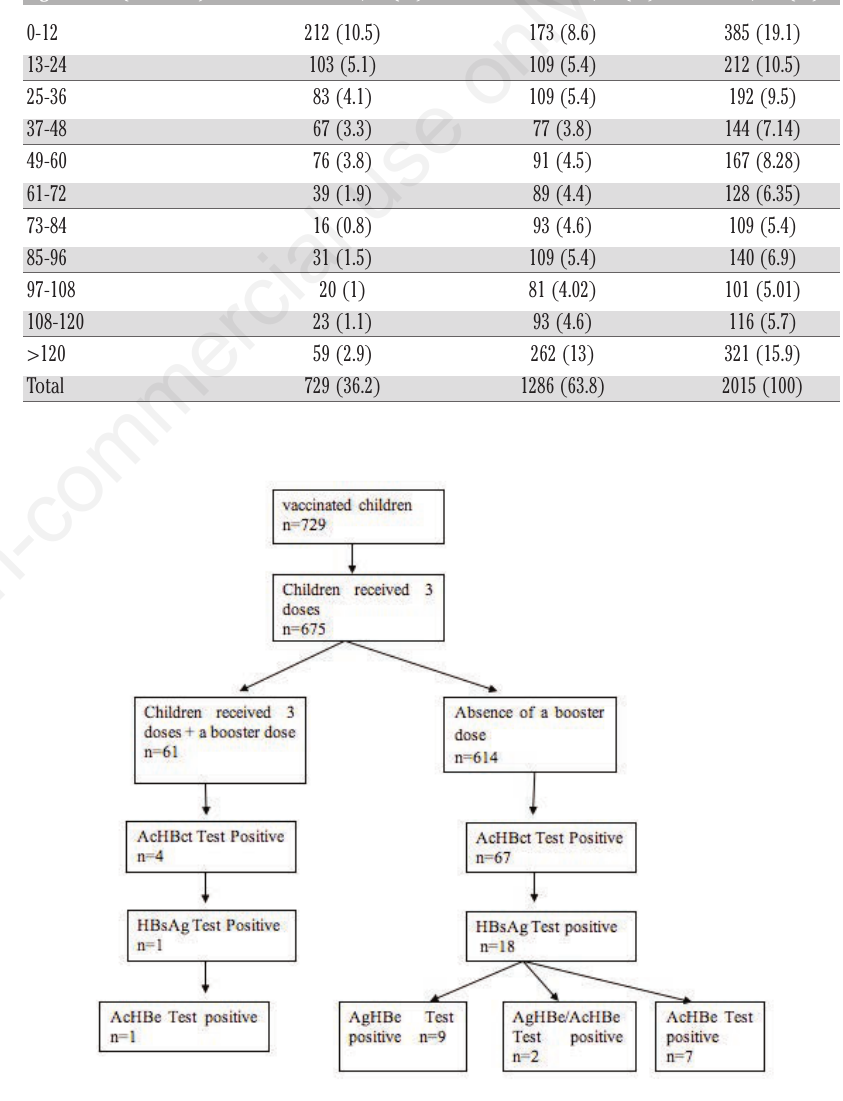
Figure 1. Serological markers according to the number of booster doses of vaccination against hepatitis B.